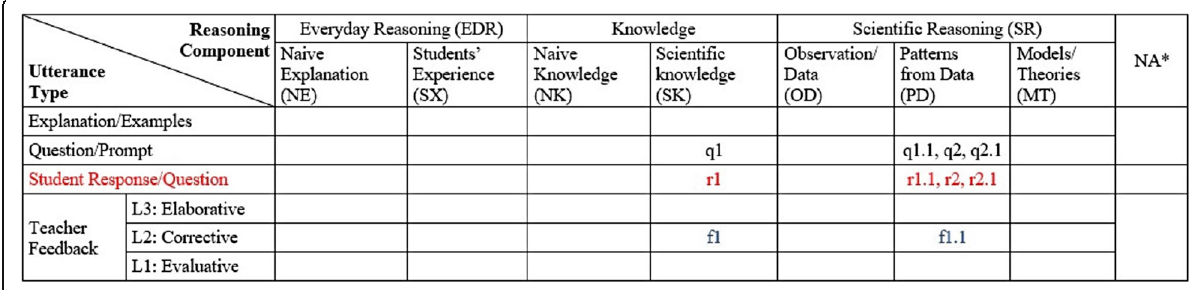
Fig. 2 An example of CDAT table coded with everyday reasoning, knowledge, and scientific reasoning